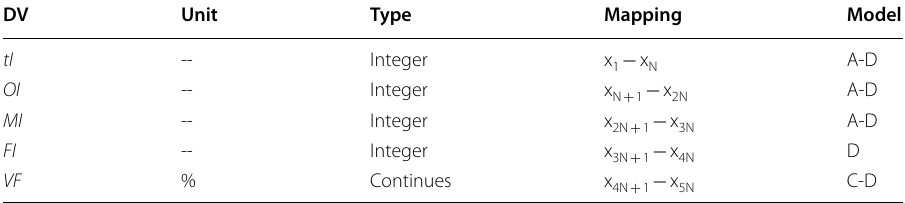
Table 4 Decision variables { P } for composite structure parameters DV